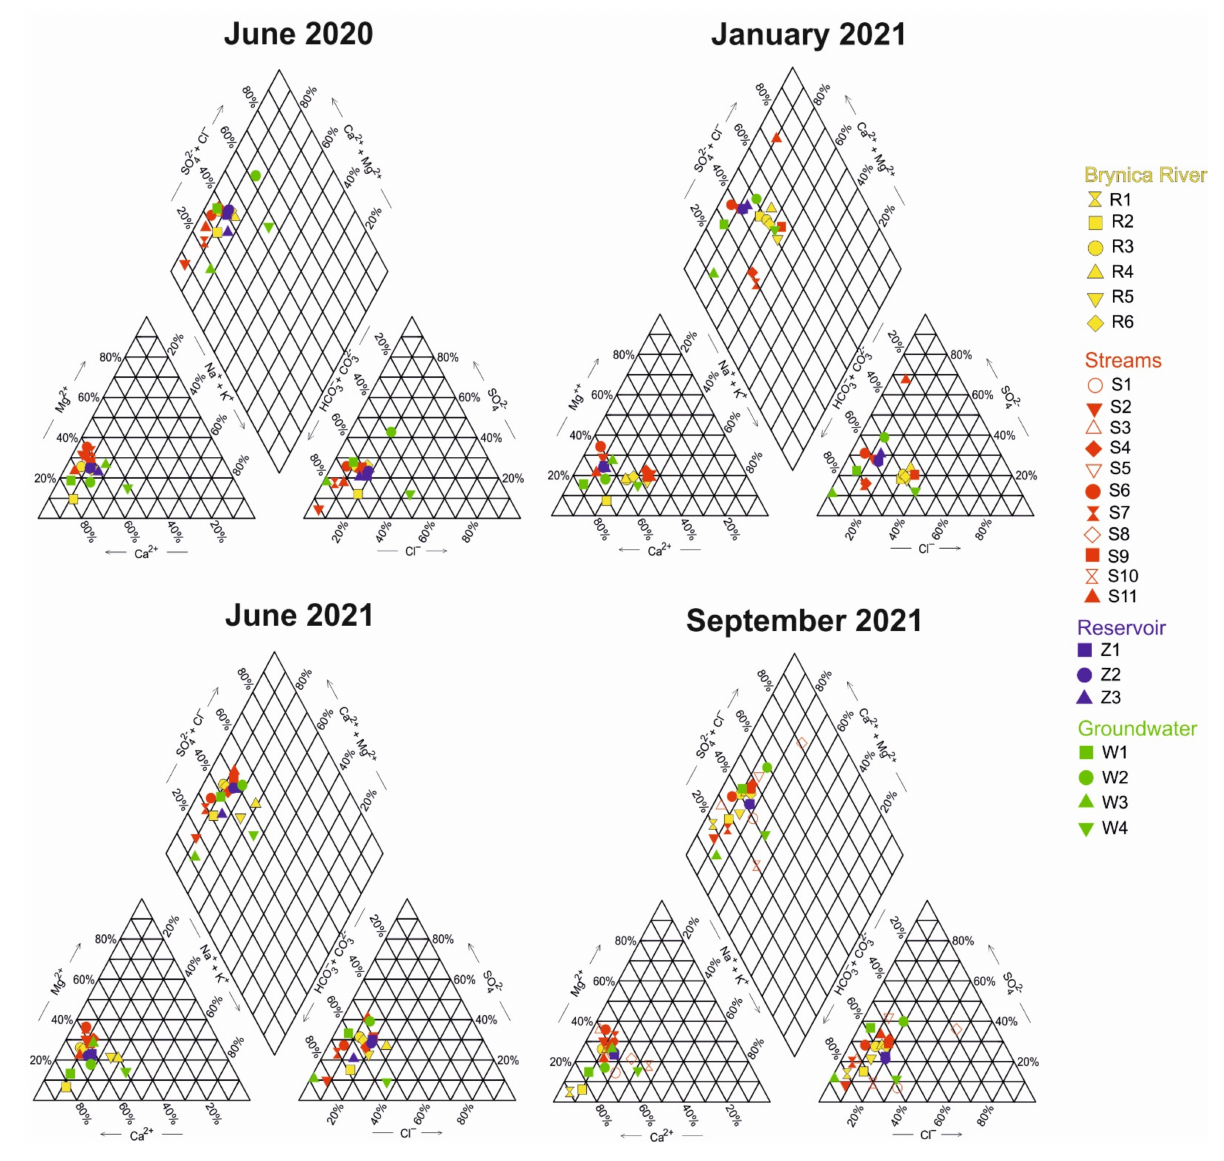
Figure 5. Piper diagrams for water samples collected in four sampling campaigns.